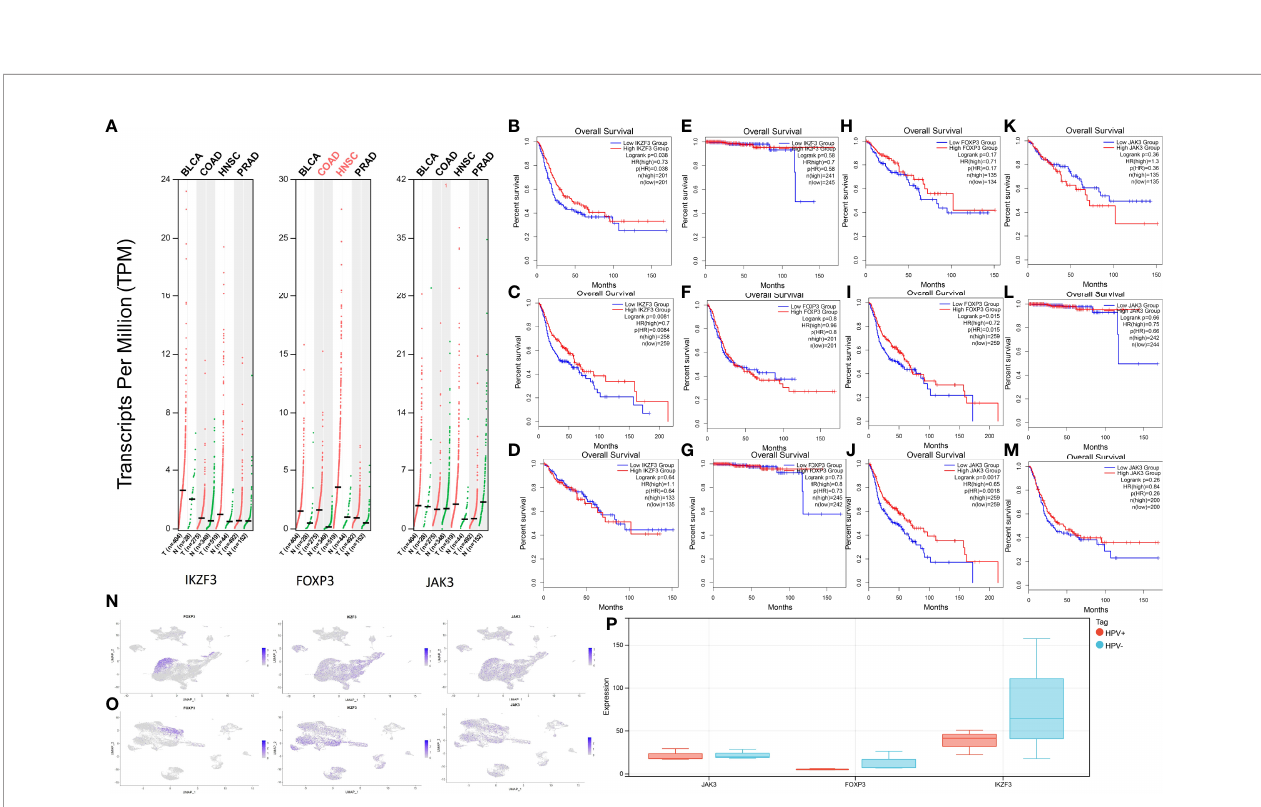
FIGURE 8 | Expression levels and survival analysis in HPV-associated cancers. (A) IKZF3, FOXP3, and JAK3 expression levels in BLCA, HNSC, PRAD, and COAD. (B) Survival analysis between high-IKZF3 and low-IKZF3 groups in BLCA. (C) Survival analysis between high-IKZF3 and low-IKZF3 groups in HNSC. (D) Survival analysis between high-IKZF3 and low-IKZF3 groups in COAD. (E) Survival analysis between high-IKZF3 and low-IKZF3 groups in PRAD. (F) Survival analysis between high-FOXP3 and low-FOXP3 groups in BLCA. (G) Survival analysis between high-FOXP3 and low-FOXP3 groups in PRAD. (H) Survival analysis between high-FOXP3 and low-FOXP3 groups in COAD. (I) Survival analysis between high-FOXP3 and low-FOXP3 groups in HNSC. (J) Survival analysis between high-JAK3 and low-JAK3 groups in HNSC. (K) Survival analysis between high-JAK3 and low-JAK3 groups in COAD. (L) Survival analysis between high-JAK3 and low-JAK3 groups in PRAD. (M) Survival analysis between high-JAK3 and low-JAK3 groups in BLCA. (N) Expressions of FOXP3, IKZF3, JAK3 in scRNA-seq HPV- HNSC. (O) Expressions of FOXP3, IKZF3, JAK3 expression in scRNA-seq HPV+ HNSC. (P) Quanti fi cation of FOXP3, IKZF3, JAK3 in bulk RNA-seq HPV+ and HPV-